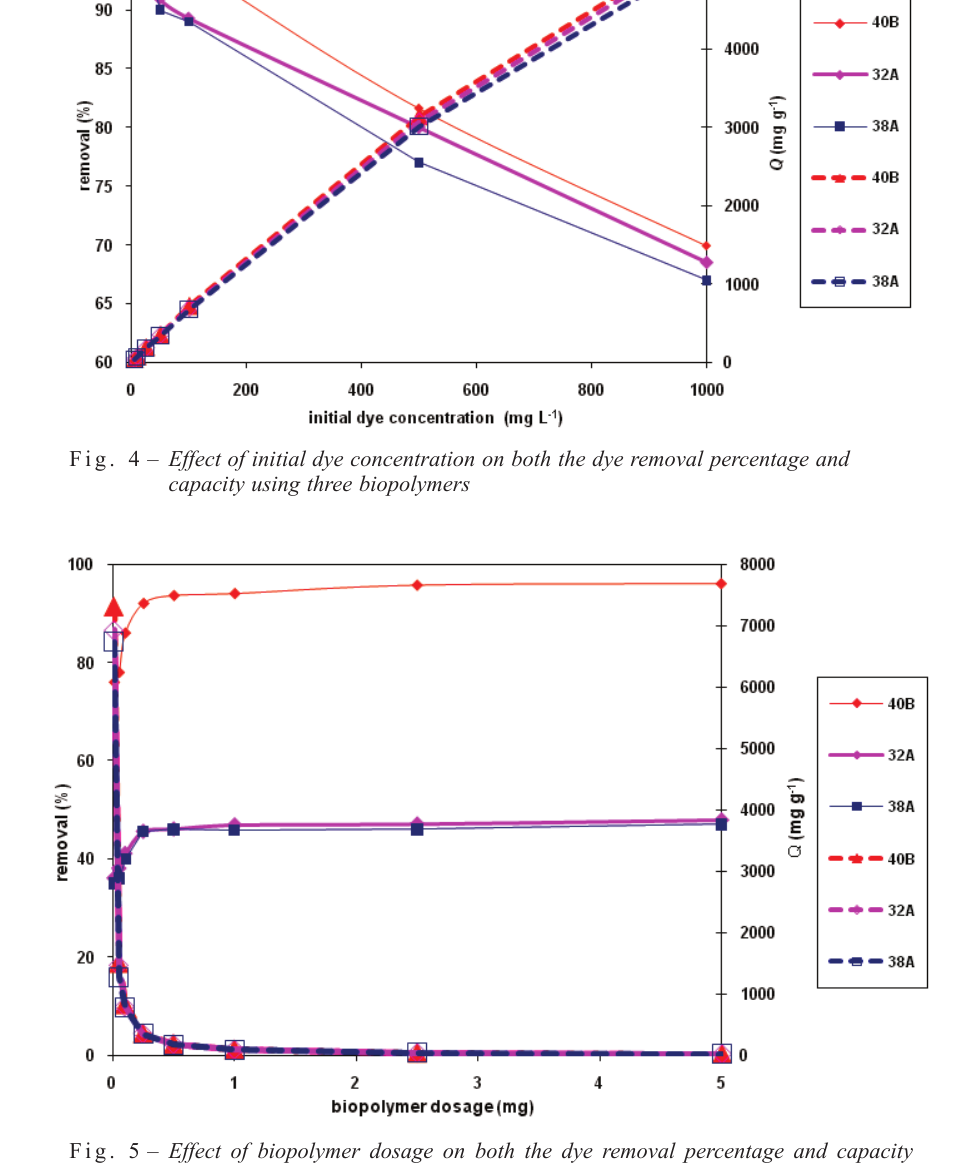
Fig. 5 – Effect of biopolymer dosage on both the dye removal percentage and capacity using the three extracted